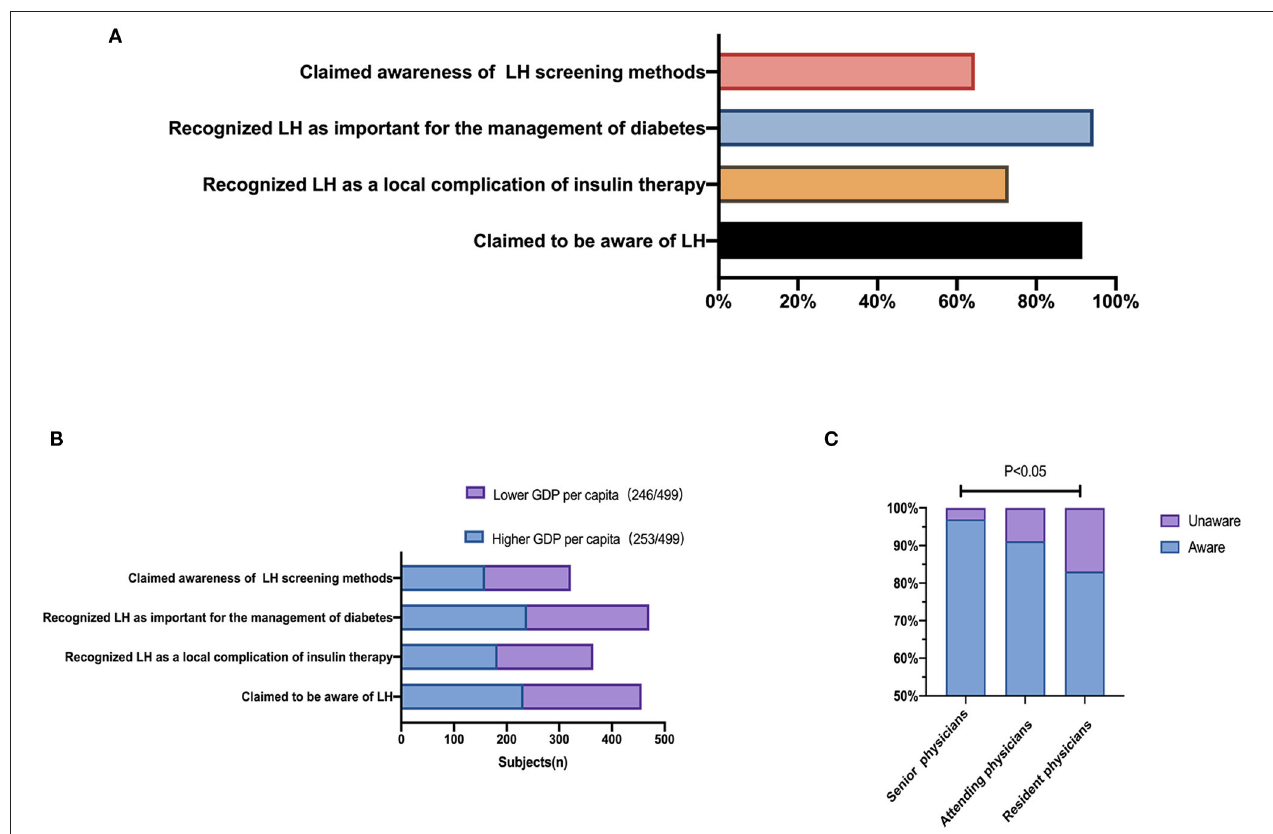
FIGURE 2 | Recognition of lipohypertrophy. (A) Proportions of physicians who reported awareness of LH. (B) Proportions of physicians aware of LH according to the GDP per capita of the region their hospital serves. (C) Proportions of physicians aware of LH according to different professional titles.